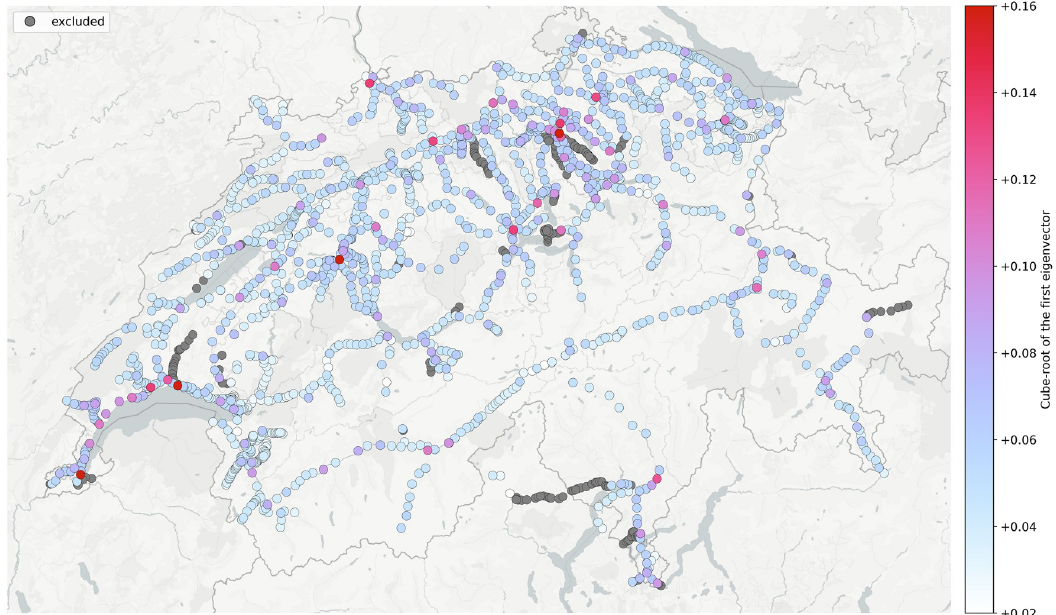
Fig 3. Single day view of the stationary distribution (1 st